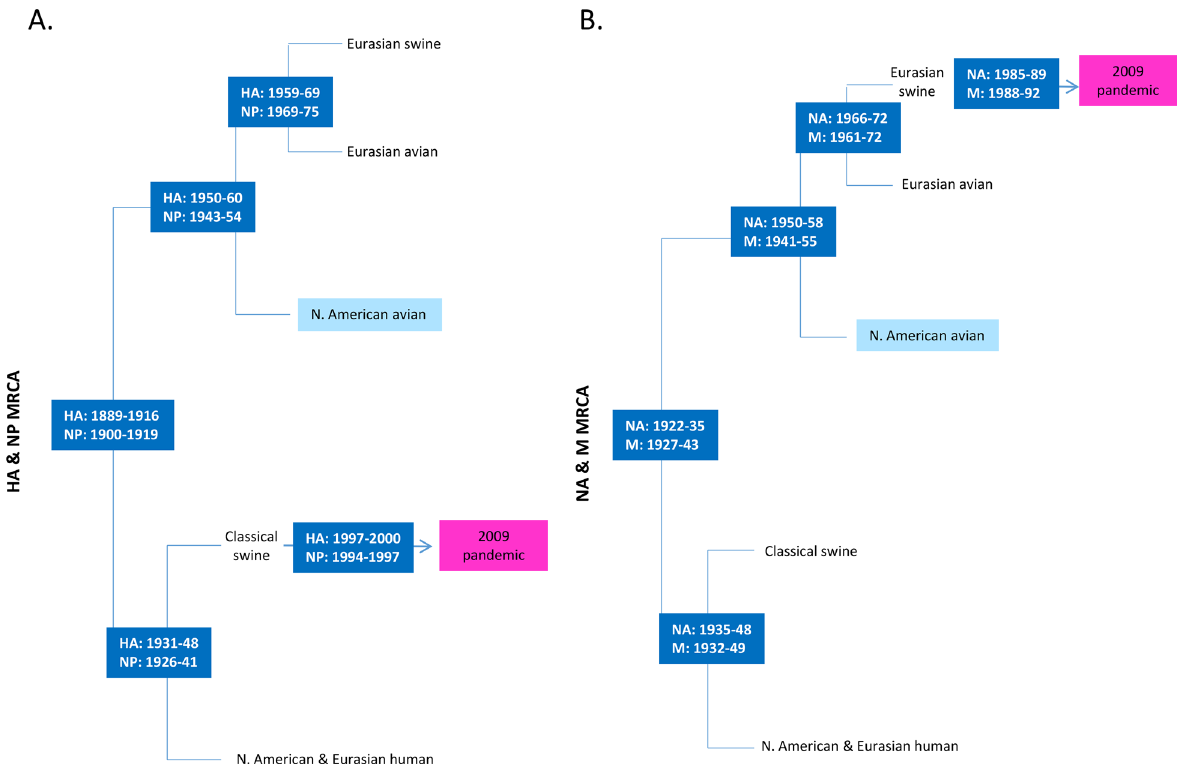
Fig 4. Schematic of the evolutionary history among HA, NP, NA and M segments of H1N1 IAVs. The schematic view is based on the phylogenetic trees of avian, swine, and human origin H1N1 IAVs and the most recent common ancestor (MRCA) for (A) HA and NP gene segments and (B) NA and M gene segments. North American avian (light blue) and 2009 pandemic H1N1 viruses (pink) are highlighted.